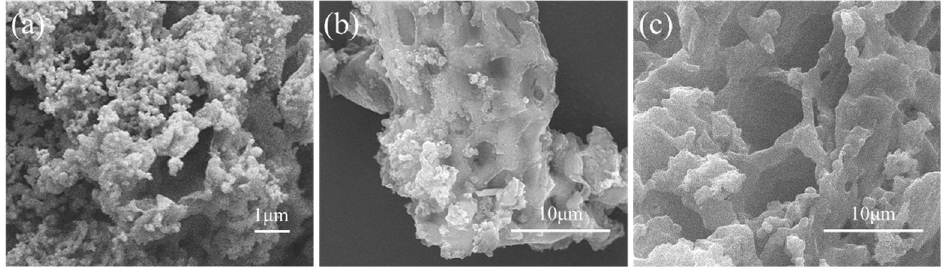
Figure 4. Scanning electron microscopy (SEM) images of ( a ) 500× Hydrochar; ( b ) 5000× BC-H 3 PO 4 ; ( c ) 5000× BC-ZnCl 2 . ( c ) 5000 × BC-ZnCl 2